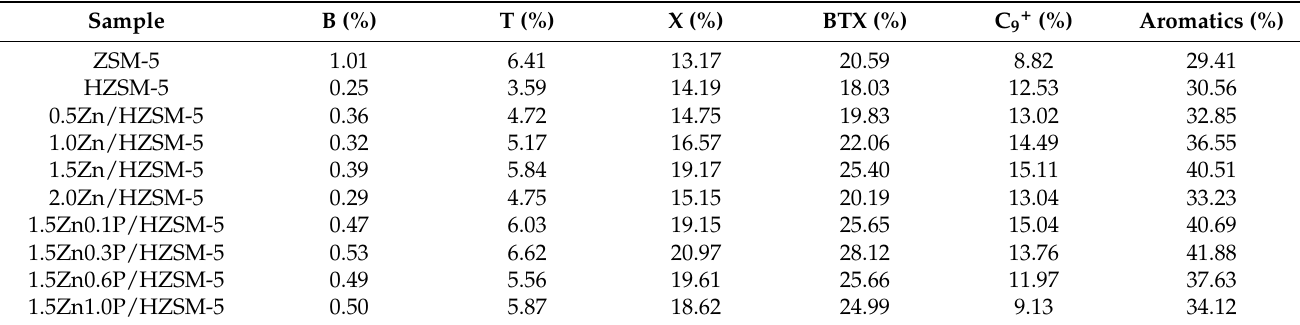
Table 3. Distribution of methanol to aromatics (MTA) products over Zn modified and Zn-P co-modified samples.